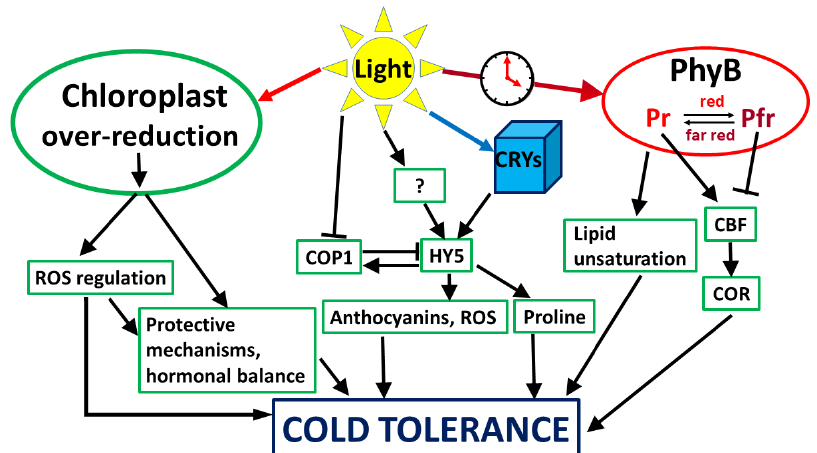
Figure 1. Possible main factors playing a role in light–low-temperature interactions in plants. There are two main routes for how light during the acclimation period may improve cold tolerance of plants. One is related to the photosynthetic processes, where the excitation pressure of the electron transport chain may induce protective mechanisms. In this case, light intensity may also determine the level of cold tolerance. The other way is determined by light spectrum, and it is related to photoreceptors, such as PhyB and Crys, which may also mediate stress-related processes. For more details, see text.